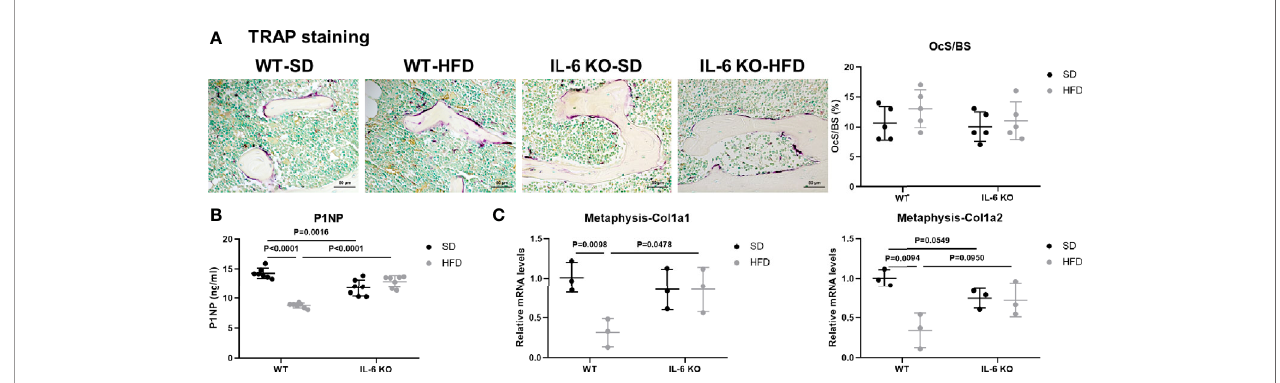
FIGURE 3 | IL-6 KO rescued the decreased osteogenesis in HFD-induced obesity. (A) Histopathological analysis on bone sections from tibia stained with TRAP staining from WT and IL-6 KO mice after SD or HFD treatment (scale bar = 50 m m). Osteoclast surface per bone surface (OcS/BS) was evaluated in tibia (right panel). (B) Bone formation marker PINP was measured in serum of WT and IL-6 KO mice after SD or HFD. (C) The mRNA levels of osteogenic markers Col1a1 and Col1a2 were measured in metaphysis of WT and IL-6 KO mice after SD or HFD. Data were expressed as mean ± SD.